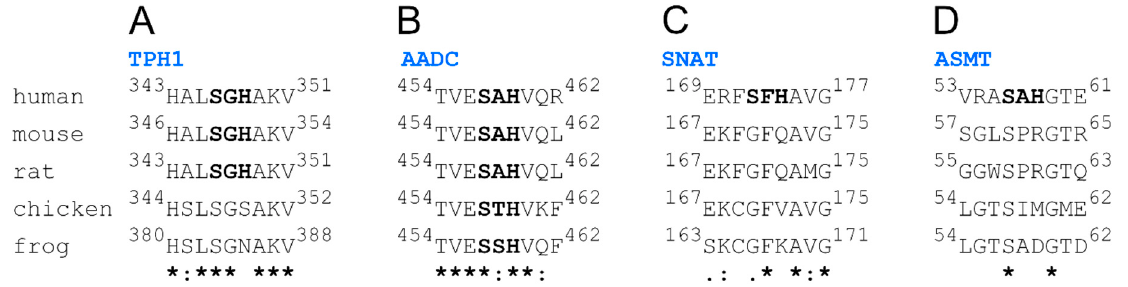
Figure 2. Multiple alignments of nine-amino-acid fragments homologous to human TPH1 ( A ), AADC ( B ), SNAT ( C ), and ASMT ( D ) parts with the Ser-Xaa-His sequences.